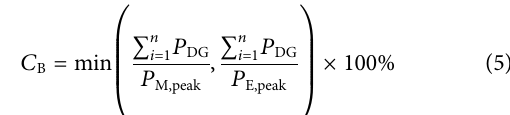
FIGURE 1 | Schematic diagram of dual excitation control